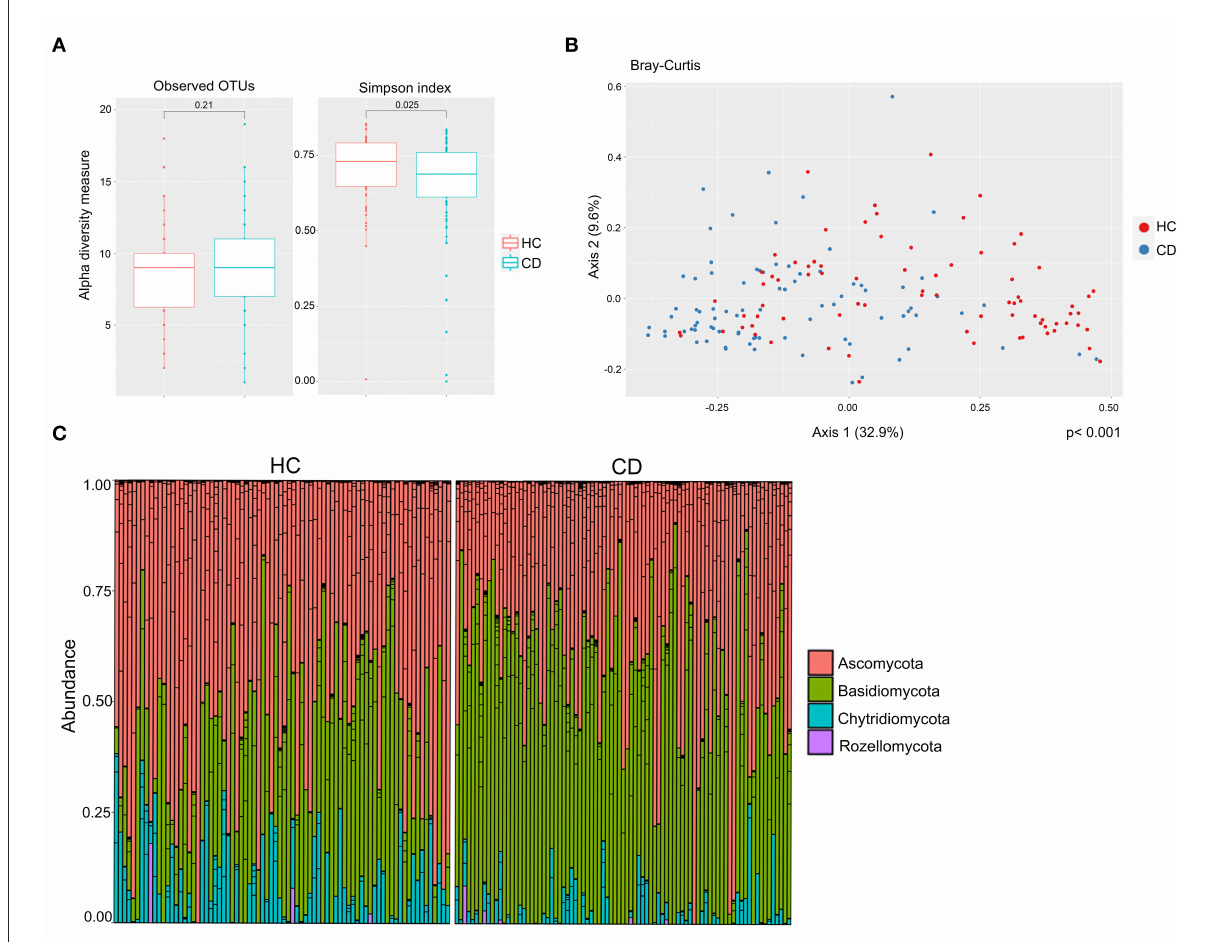
FIGURE1 The mucosa-associated mycobiota in Crohn’s disease (CD) patients ( n = 44) was altered in comparison to healthy controls (HC) ( n = 40). (A) Alpha-diversity, according to observed operational taxonomic units (OTUs) (left) and Simpson index (right), boxplots colored according to disease phenotype (HC = red, CD = blue). (B) Beta-diversity. Principal coordinates analysis of Bray–Curtis dissimilarity with samples colored according to study group, (CD = blue and HC = red). The fraction of diversity captured by the coordinate is given in percentage on axes 1 and 2. Groups were compared using the Permanova method. (C) Relative abundance of fungal phyla in HC and CD